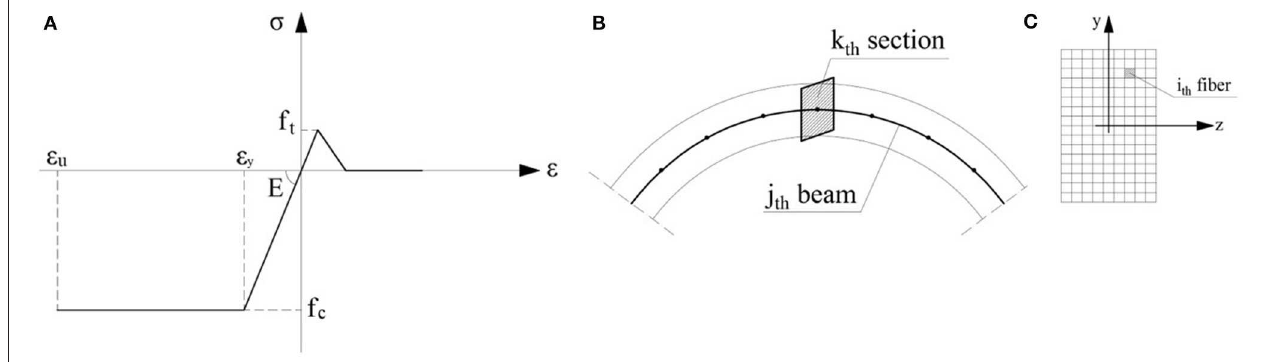
FIGURE 1 | Material and geometrical characteristics of the arch. (A) Masonry non-linear constitutive law. (B) Example of discretization of the arch with beam elements. (C) Generic reference section of